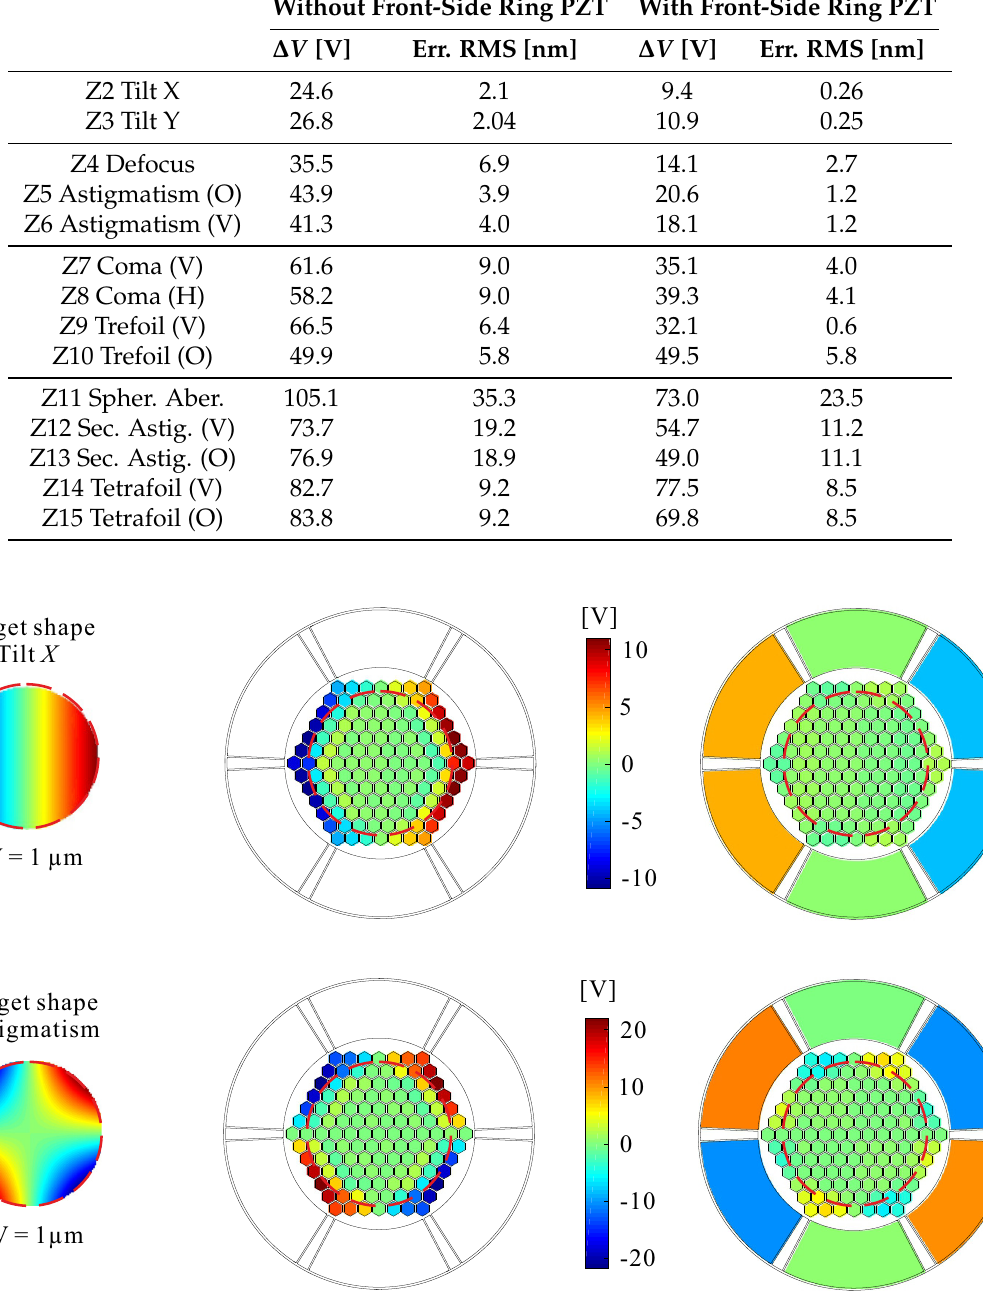
Table 2. Comparison of the control authority for the low-order Zernike modes with a PV amplitude of 1 µ m. ∆ V = V max − V min . Left: The central actuators on the back are used alone. Right: They are used jointly with the ring actuators on the front side.